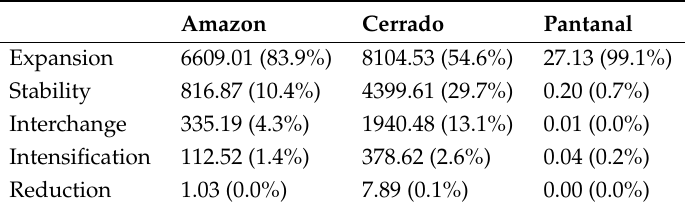
Figure 5. Patterns of agricultural practices changes from 2001 to 2017 in Mato Grosso State. Table 4. Areas (ha) of agricultural practices trajectories in Mato Grosso State, stratified by biomes, considering the period from 2001 to